Question: What kind of plot is shown here?
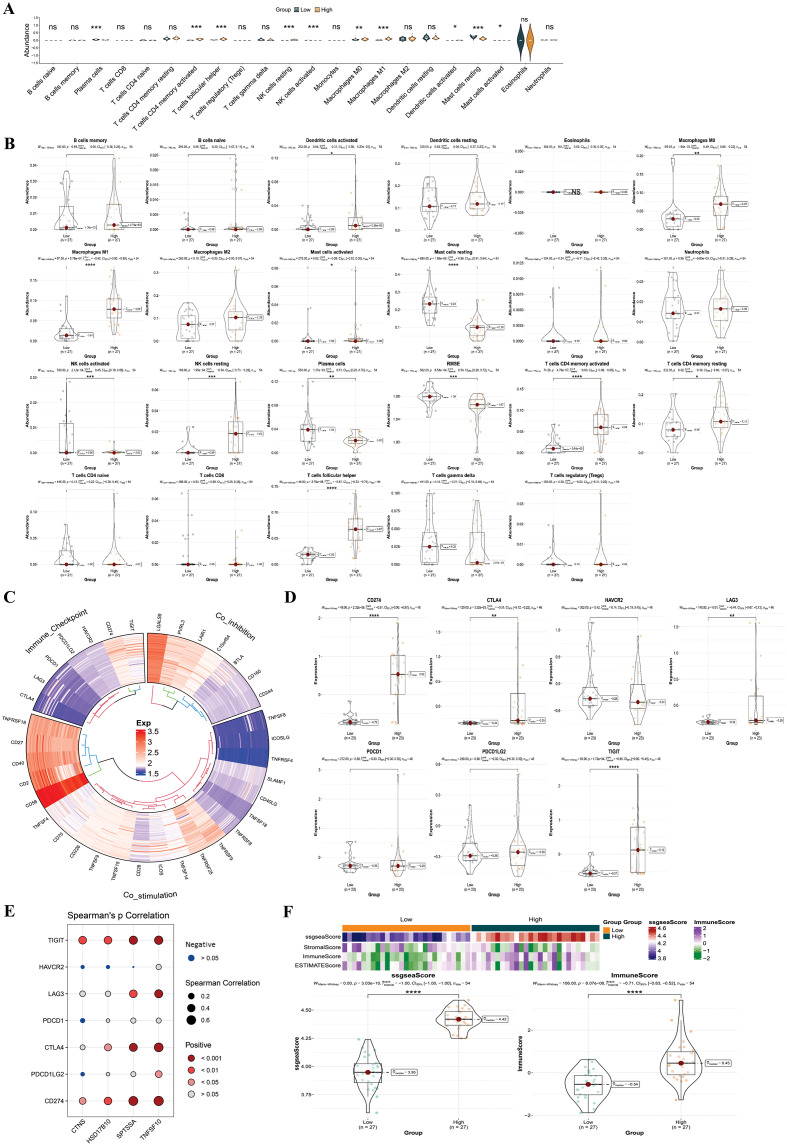
Answer: heatmap